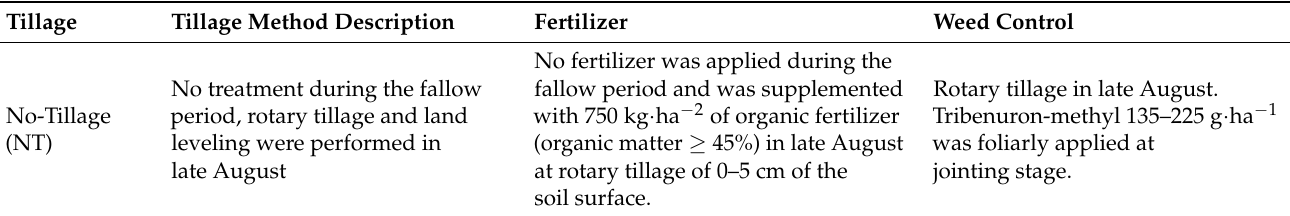
Table 2. Description of different tillage